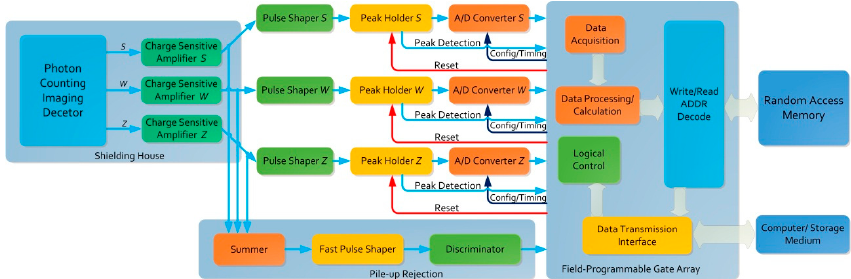
Figure 5. Block diagram of the readout circuits with the wedge strip anode. The labels S , W and Z in each module correspond to the channels of the strip electrode, wedge electrode and residual electrode, respectively. In practice, these three channels can be extended to more channels for other geometry configurations of anodes.